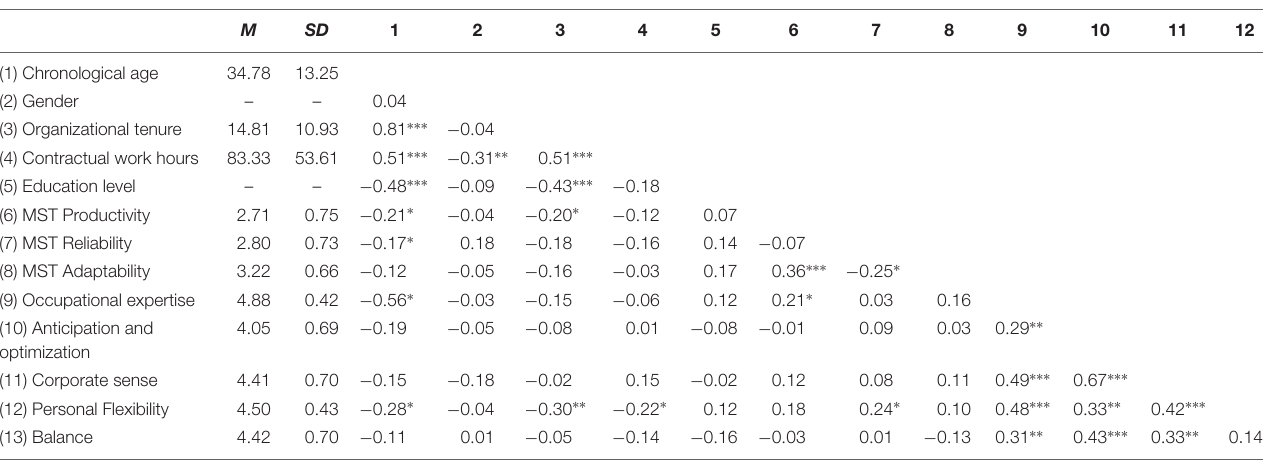
TABLE 1 | Means, standard deviations, and pearson’s correlations between study